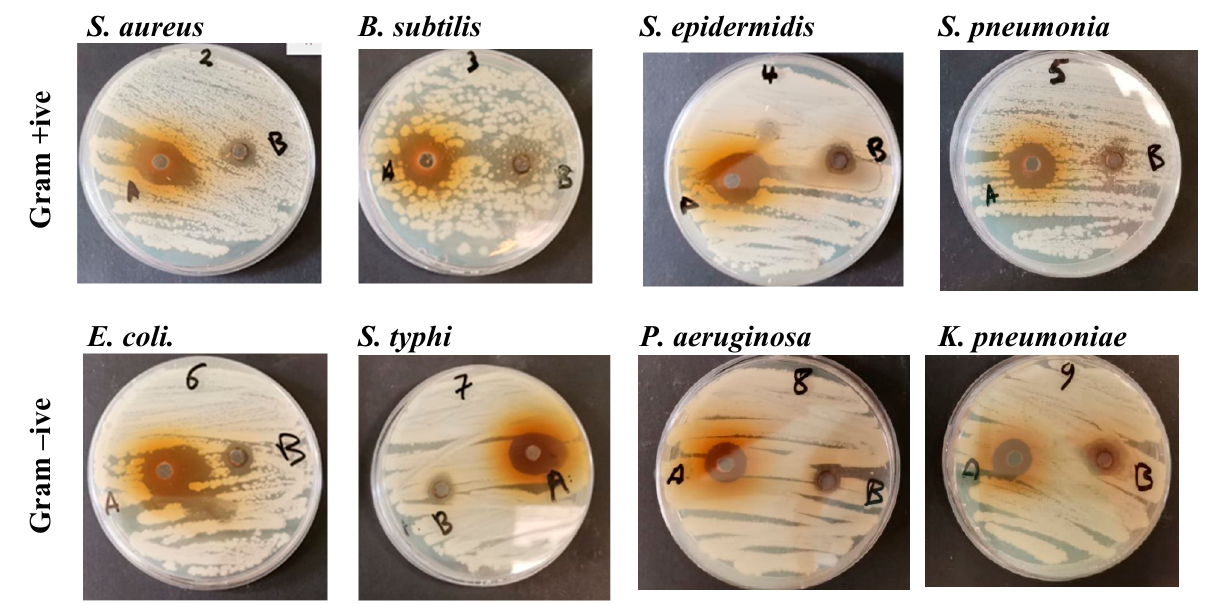
Figure 7. Zone of inhibition (mm) of AgNPs synthesized from plant extract against different gram +ive and gram − ive bacterial strains.